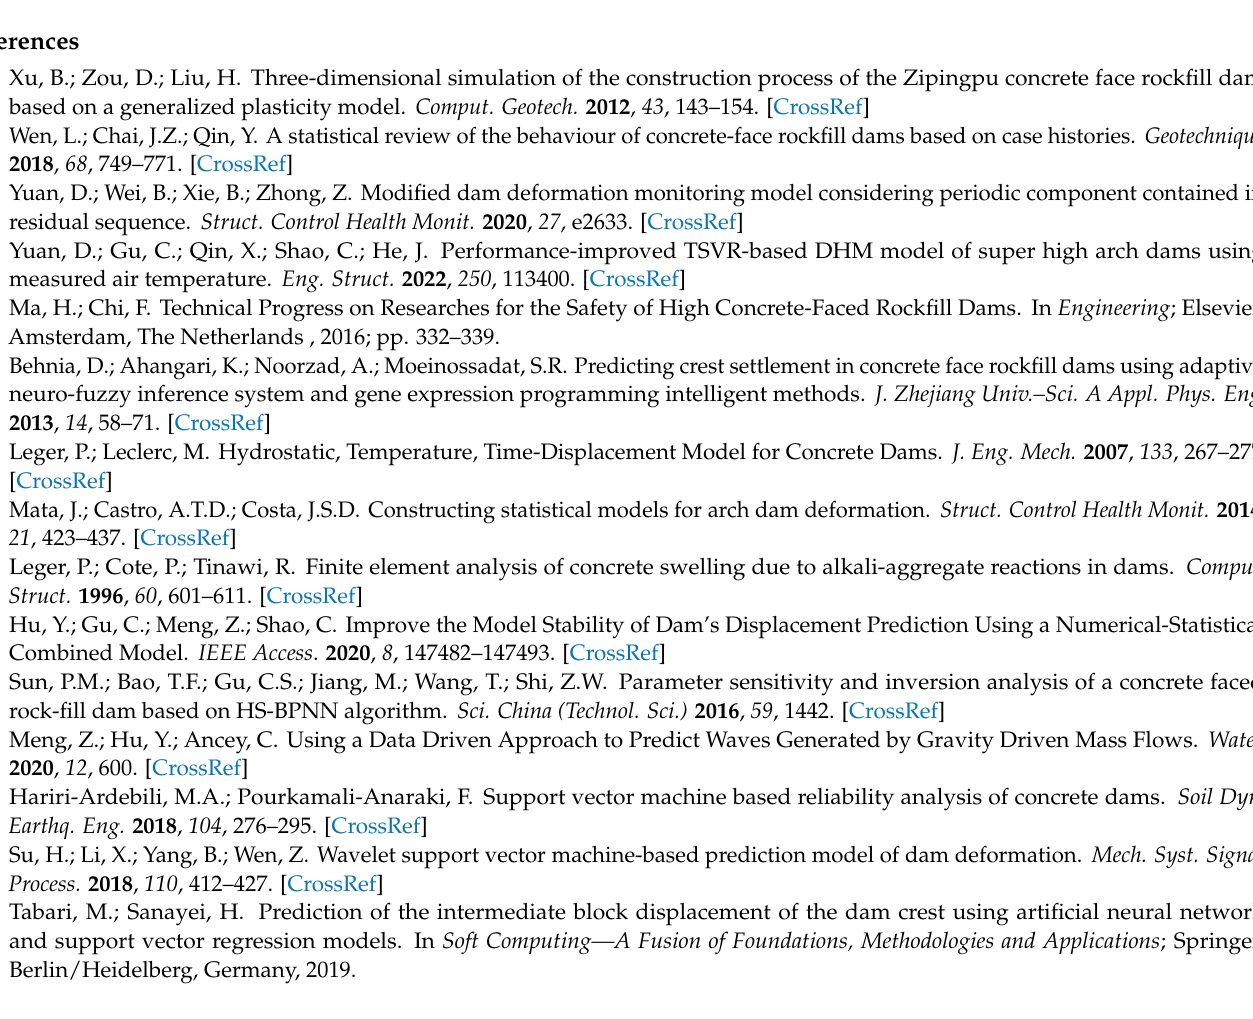
Figure A4. Fitting and prediction results of M–LSTM model based on the training datasets in Cluster 4 (LD3-2, LD4-2, LD4-3, LD5-2, LD5-3, and